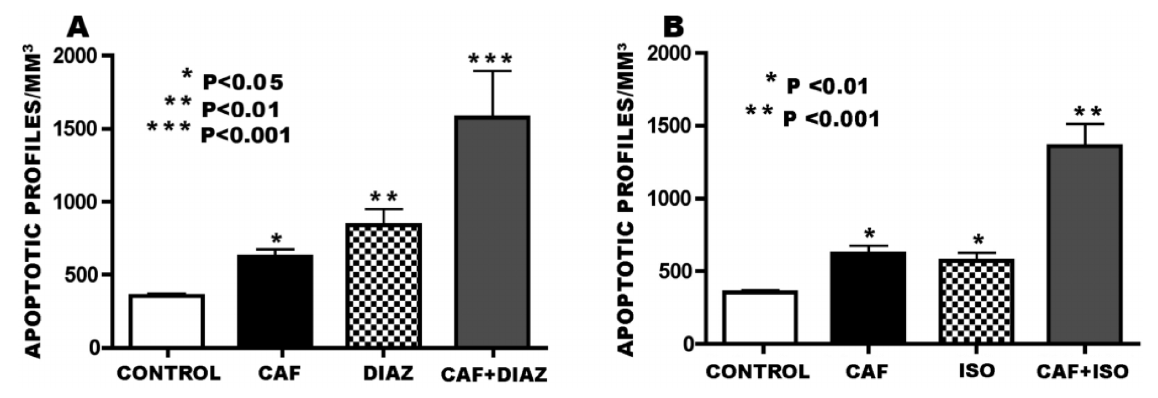
Figure 3. Apoptogenic action of CAF in combination with diazepam ( A ) or isoflurane ( B